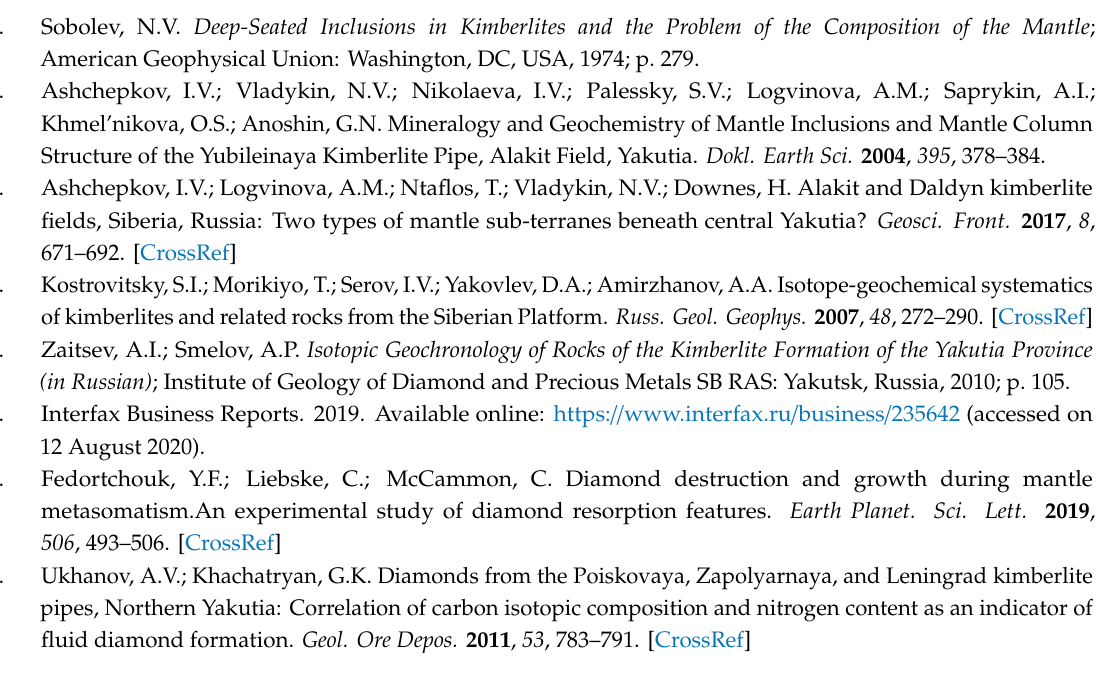
Table S1: EPMA for minerals from xenoliths and concentrates, Table S2: TRE in minerals from xenoliths and